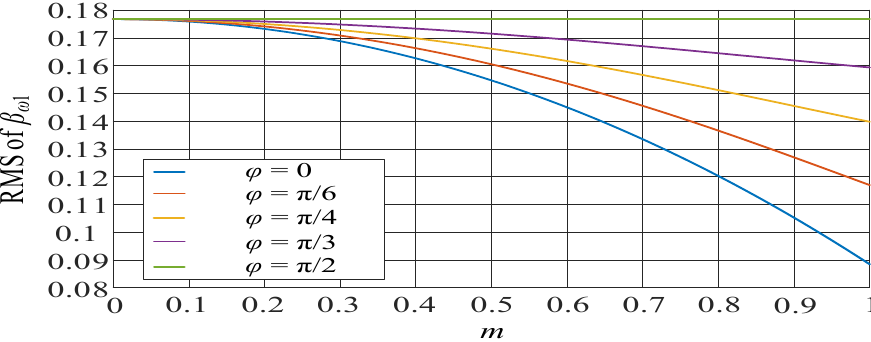
Figure 7. The RMS value of β ω